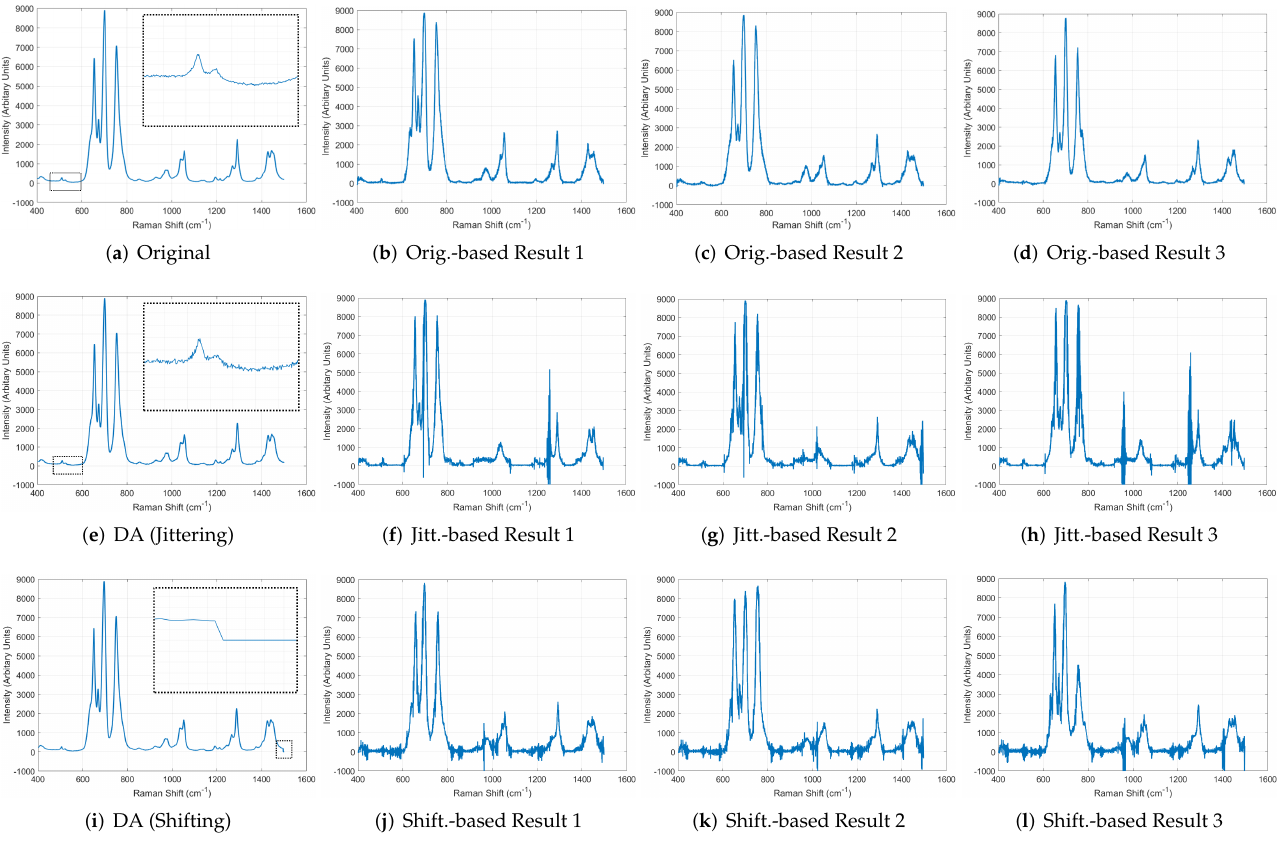
Figure 8. Performance comparison among GAN models trained using the original data and the augmented data with jittering or